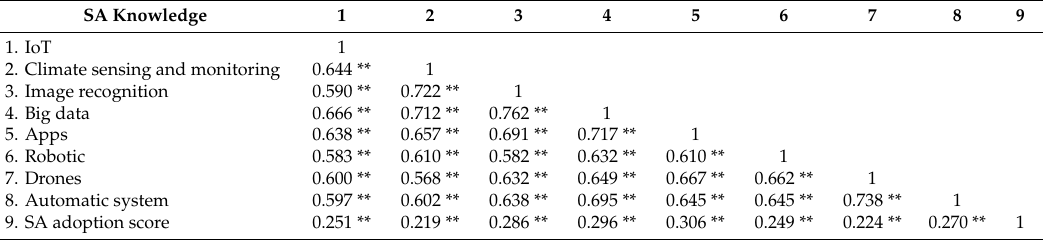
Table 3. Correlation matrix of the SA knowledge and adoption ( n = 321). SA Knowledge